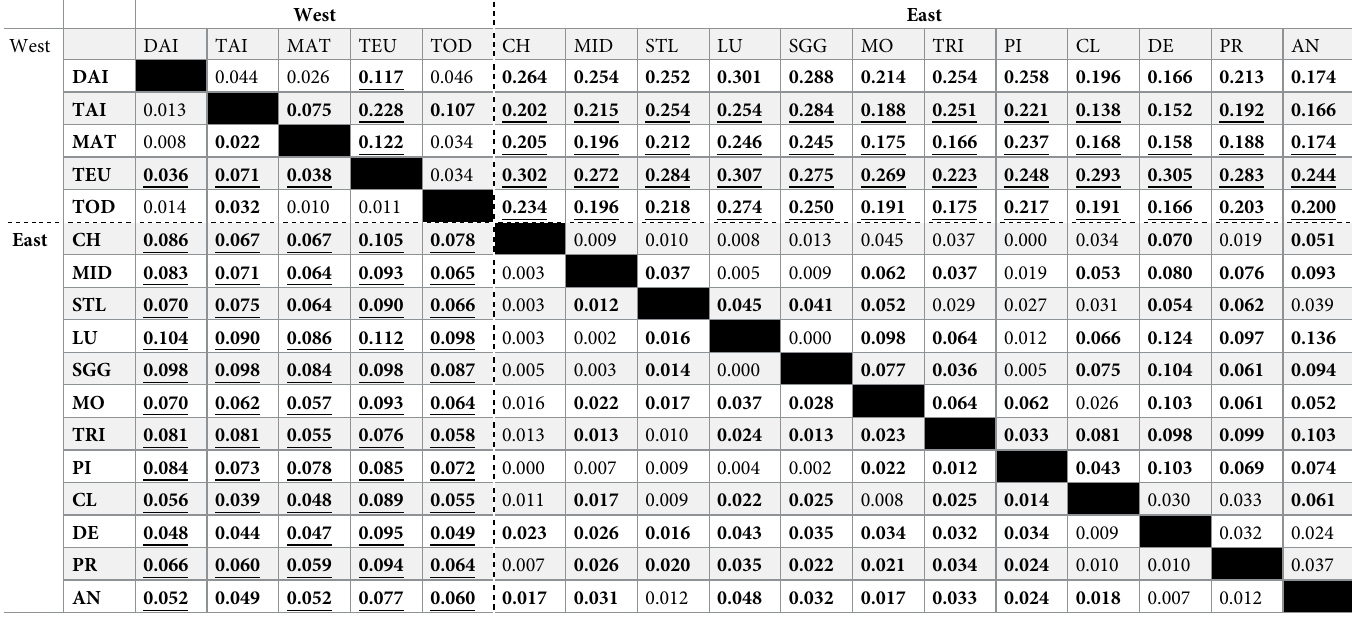
Table 3. Pairwise F ST values (below diagonal) and F ꞌ ST values (above diagonal) for 17 rhinoceros auklet breeding colonies based on nine microsatellite